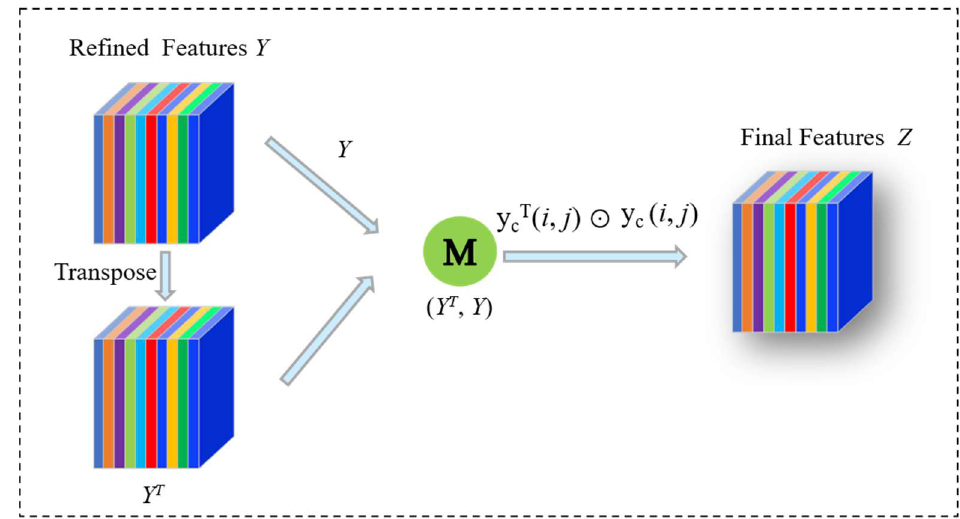
Figure 4. The architecture of self-interaction module structure.